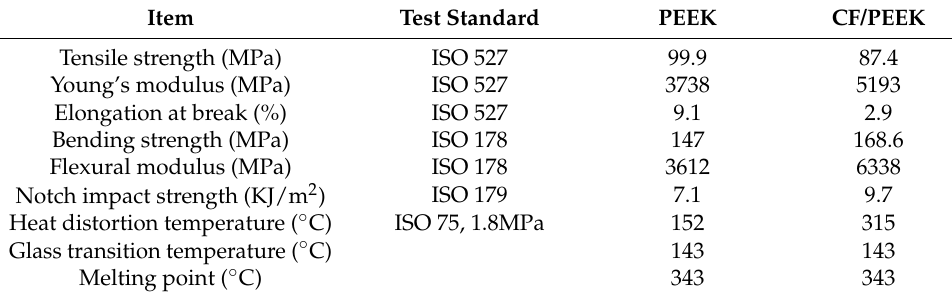
Table 1. Material properties of the experimental PEEK and CF/PEEK.